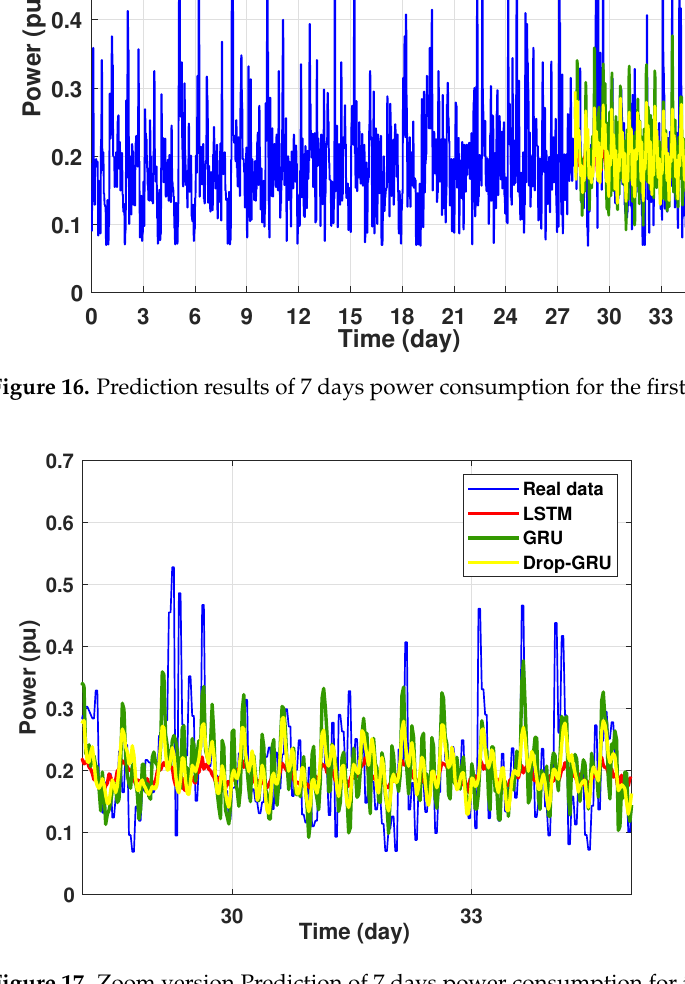
Figure 17. Zoom version Prediction of 7 days power consumption for the first